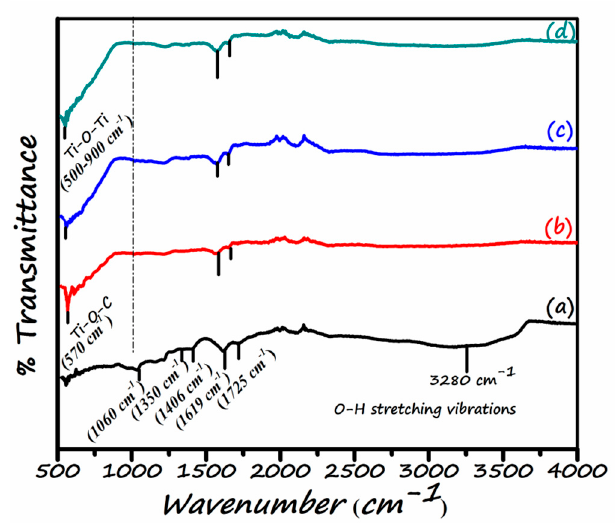
Figure 7. FT-IR spectra of ( a ) GO ( b ) NC-1 ( c ) NC-2 ( d ) NC-3.